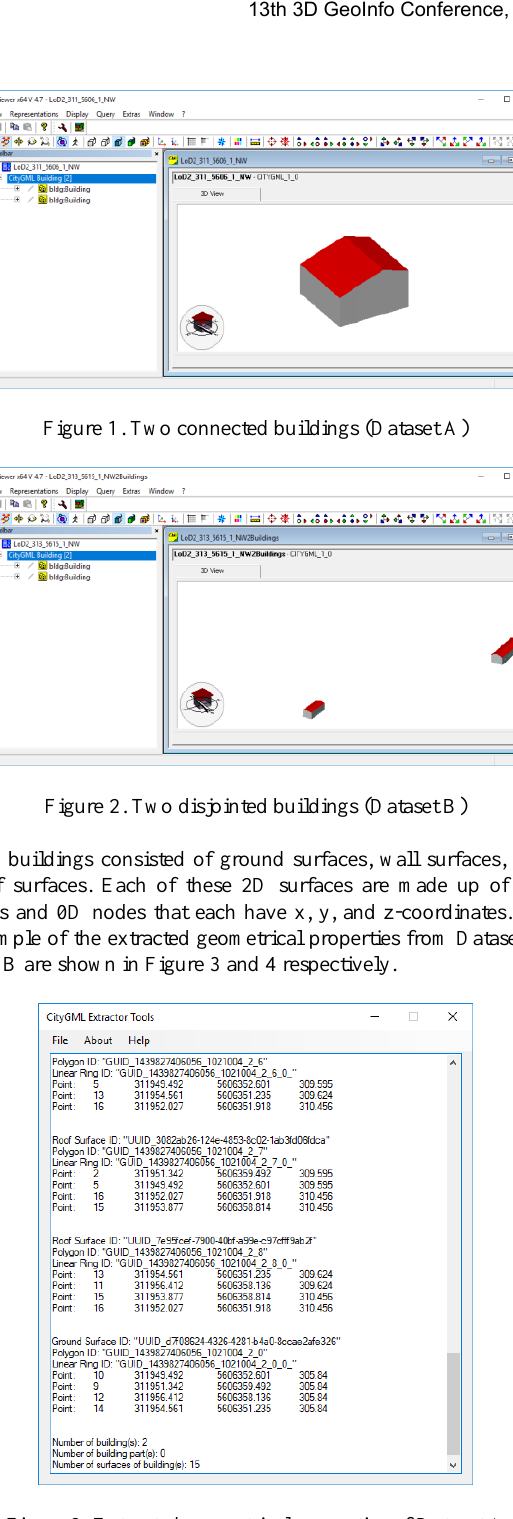
Figure 3. Extracted geometrical properties of Dataset A The connected buildings in Dataset A consisted of a total of 15 surfaces and 16 nodes. Meanwhile, the disjointed buildings in Dataset B is made up of 18 surfaces and 20 nodes.